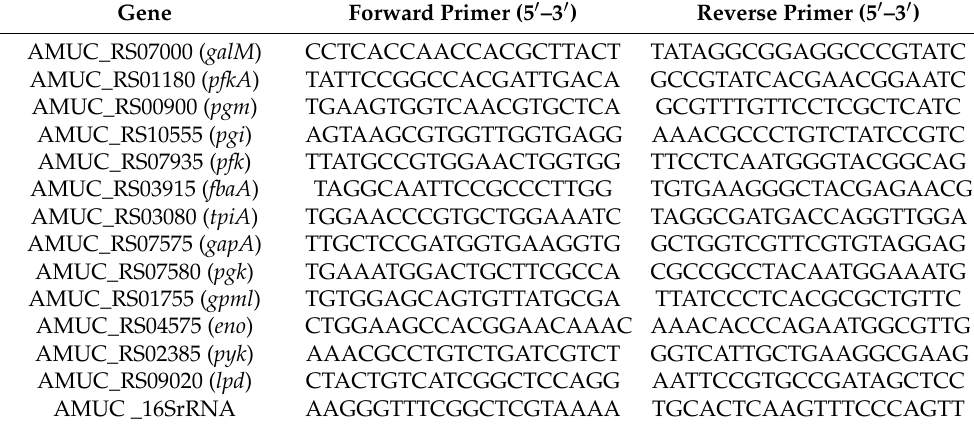
Table 1. List of primers for